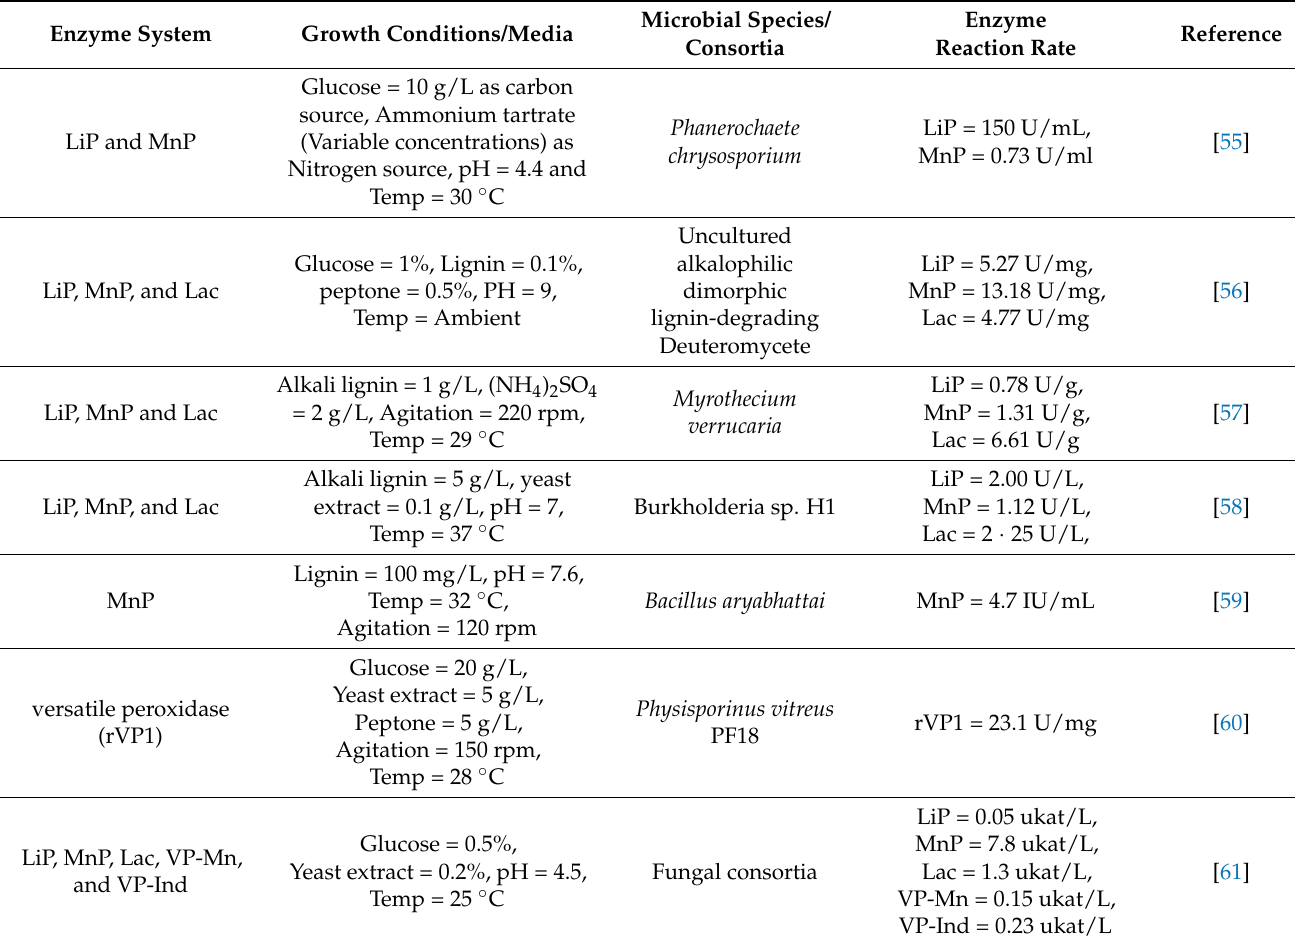
Table 2. Culture enhancement strategies to produce